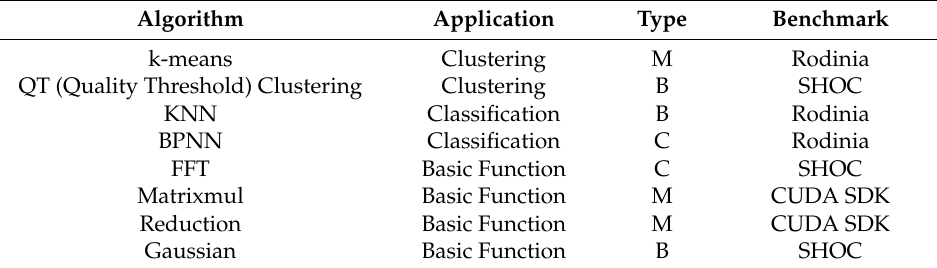
Table 1. The benchmarks.